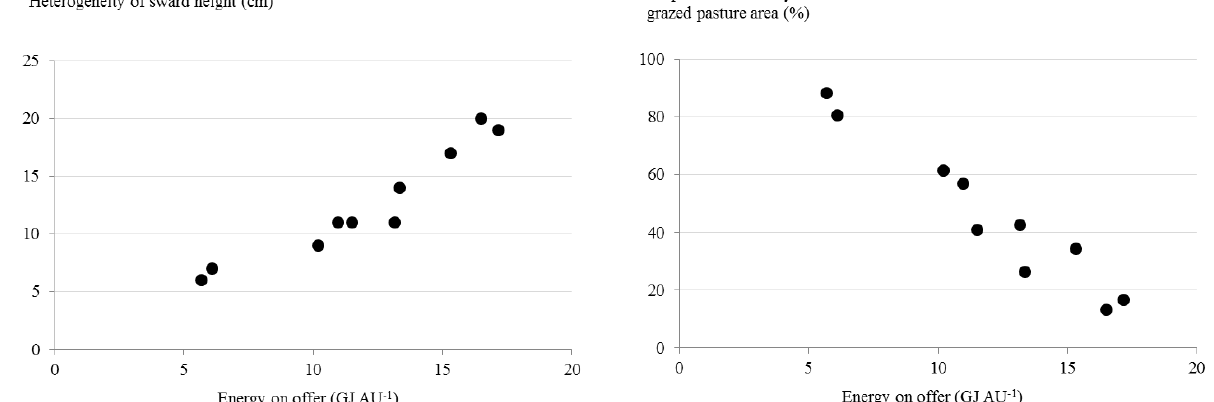
Figure 3. Heterogeneity of compressed sward height (Q pasture area (right) as a function of the energy on offer per animal unit. Data obtained during the grazing season of 2000, on five consecutive sampling dates (see Table 2) and two pasture